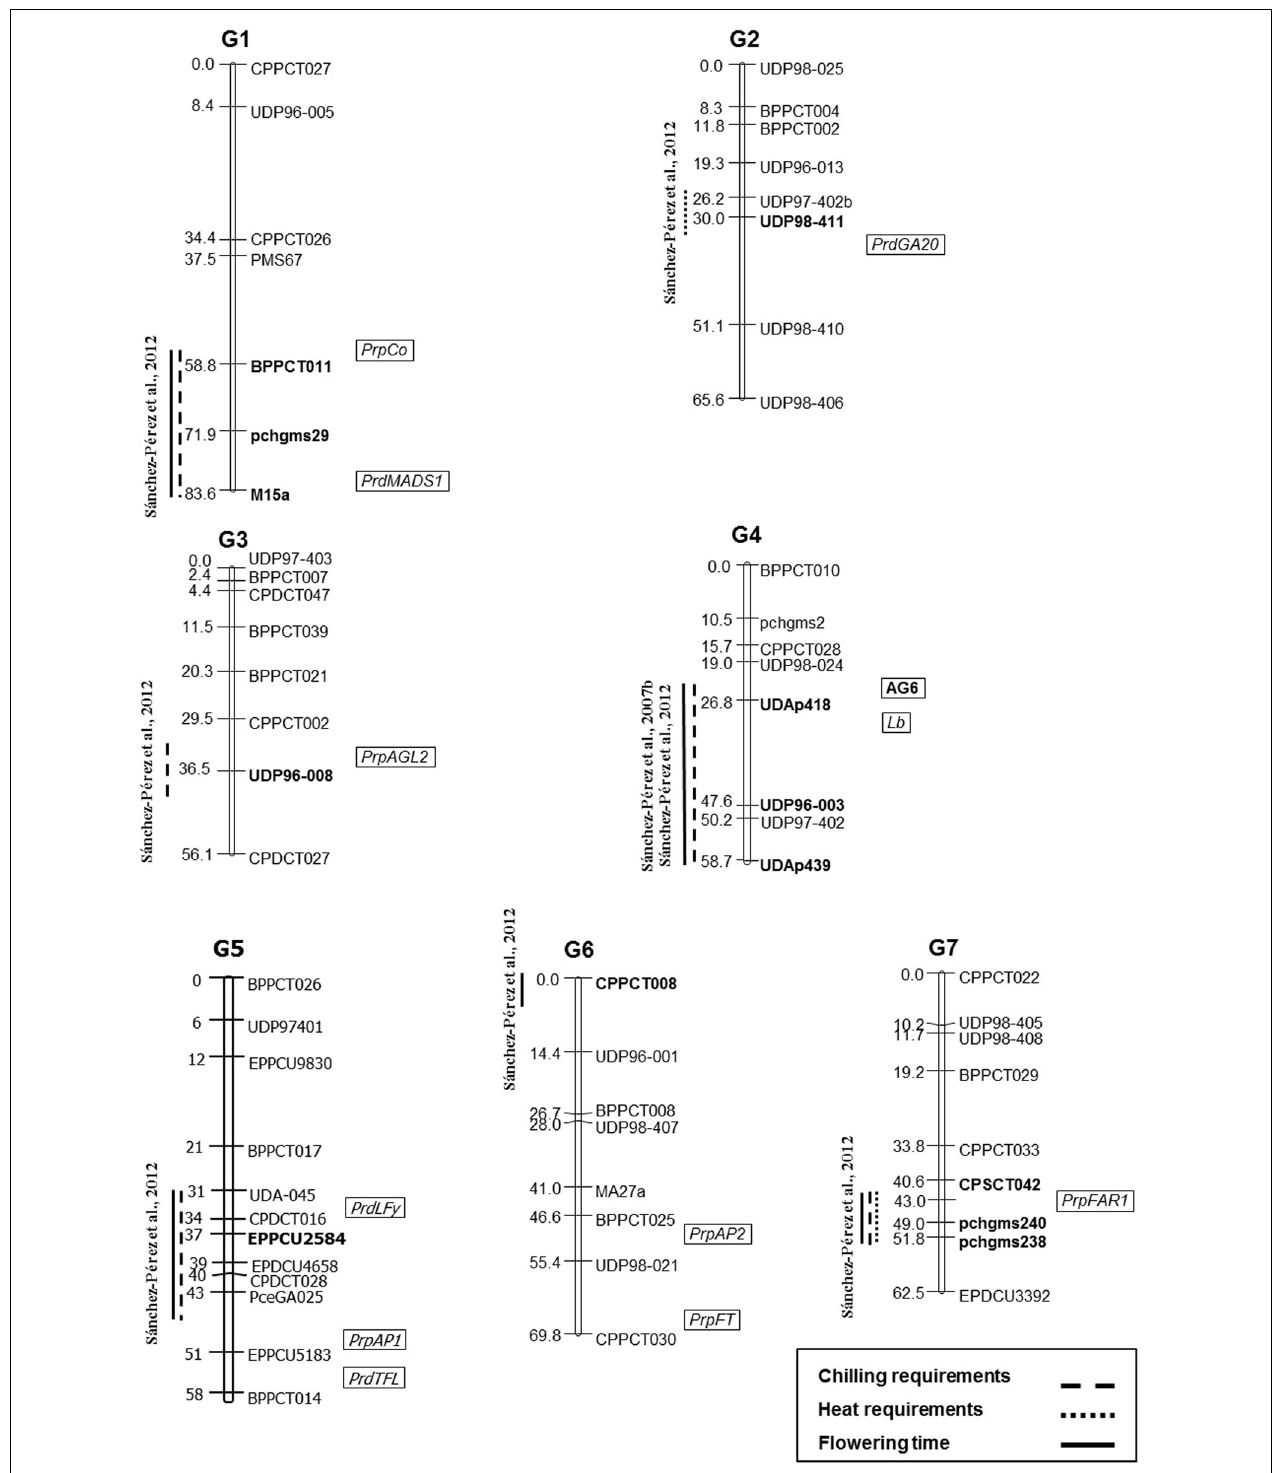
FIGURE 1 | Location of QTLs linked to flowering time and chilling and heat requirements in the almond map from the population R1000 × Desmayo Largueta performed by Sánchez-Pérez et al. (2007b, 2012). The closest SSR marker linked to the QTL is marked with bold lettering on this map. The approximately location of the RAPD marker (AG6) (Ballester et al.,